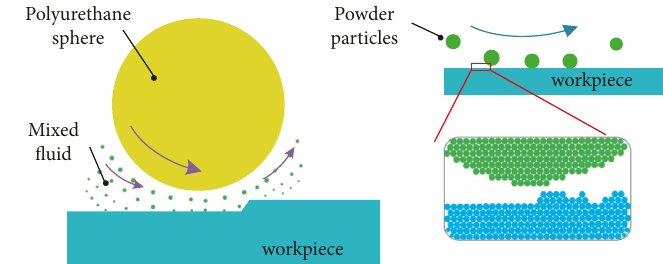
Figure 15: Elastic emission machining principle.